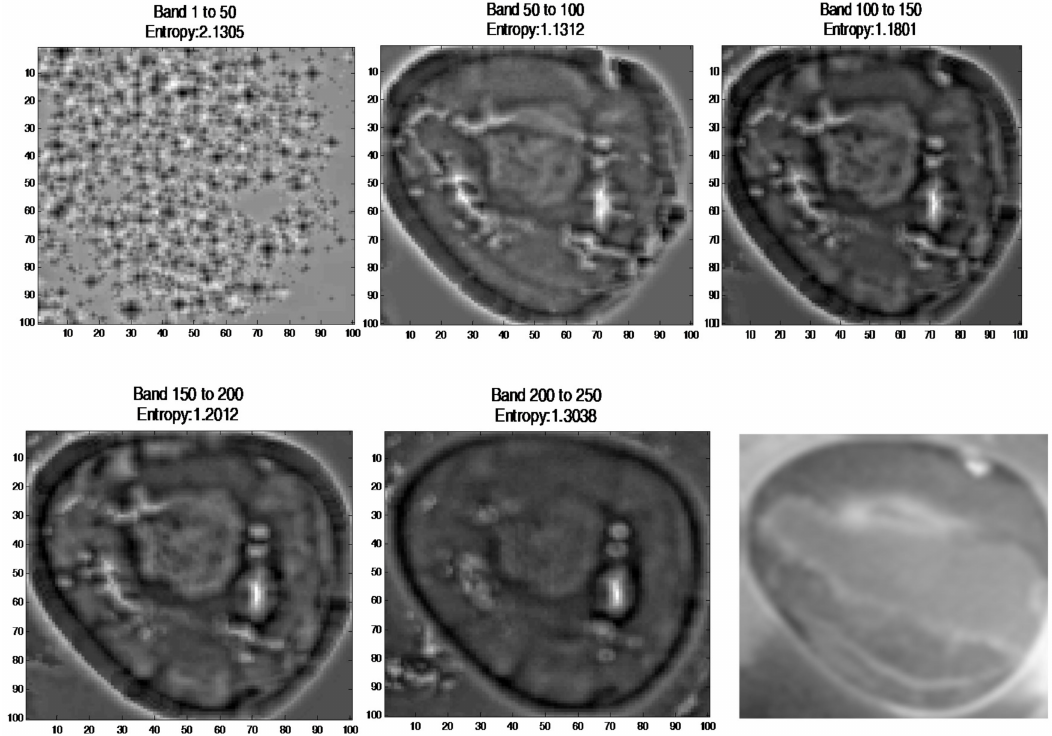
Figure 13. Output image at band 1 to 50, 50 to 100, 100 to 150, 150 to 200, and 200 to 250. Image at row 2 column 3 is a ground truth